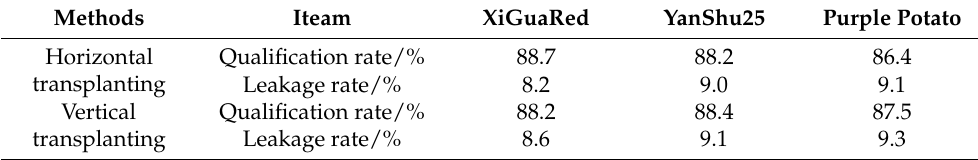
Table 6. Transplanting results at 0.25 m/s.